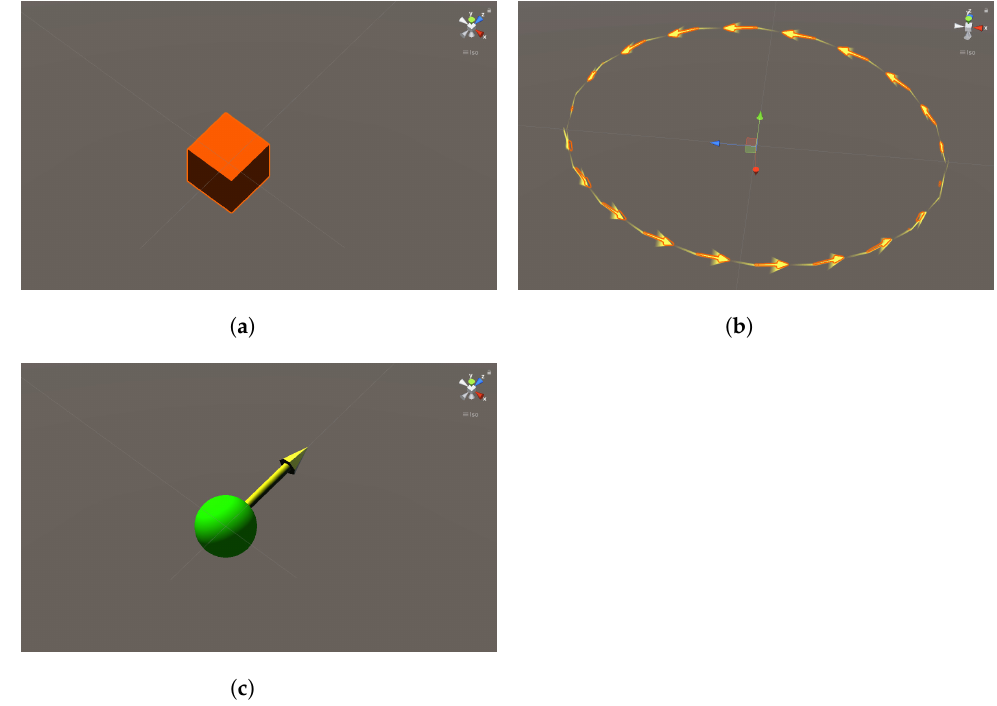
Figure 6. Proposed holograms for the robot references. ( a ) WR: translation reference hologram. ( b ) WR: rotation reference hologram. ( c ) STR: translation reference